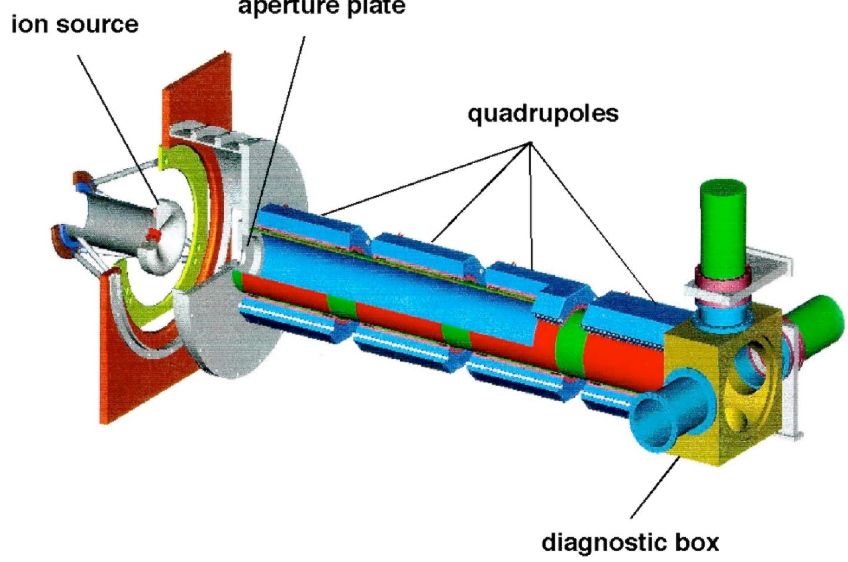
FIG. 13. (Color) NTX injector and magnetic final-focus lattice with selected areas cut away to reveal interior